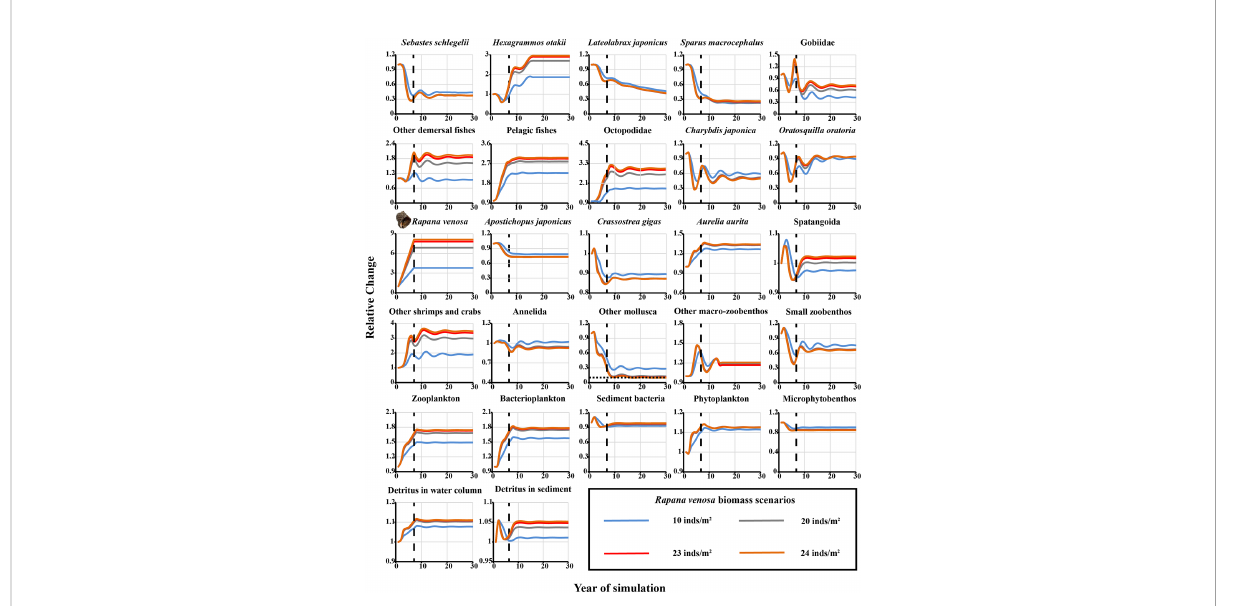
FIGURE 3 Predicted relative changes in biomass of each functional group in the Ecopath Model of Laizhou Bay marine ranching area for the selected four representative scenarios of the red snail Rapana venosa stock enhancement. Vertical dashed line, time after which the biomass level of R. venosa remained constant; horizontal dashed line, 10% threshold of initial